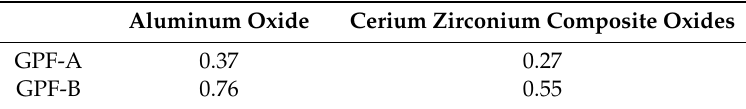
Table 4. Comparison of bulk density of GPF-A and GPF-B (g / mL).